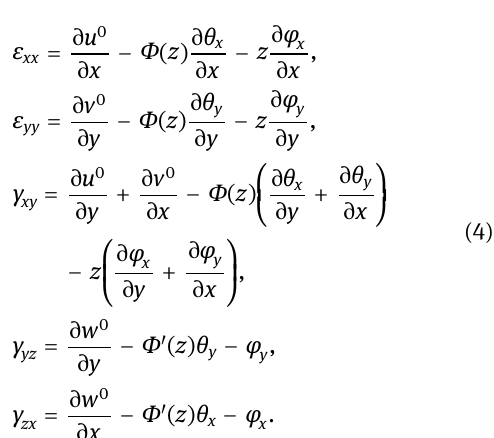
Figure 3: SFGM plate with con fi gurations ( 1 - 1 - 1 ) and ( 1 - 2 - 1 ) using Al/Al 2 O 3